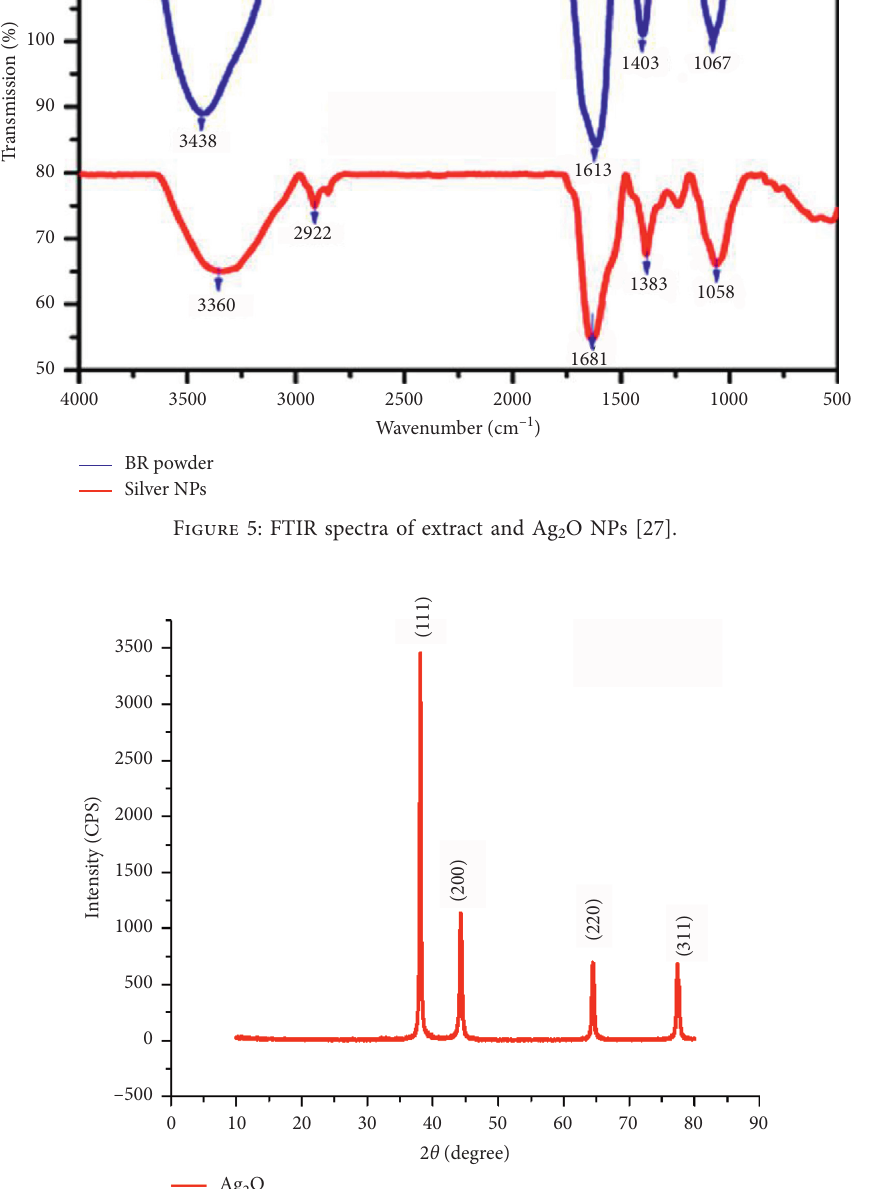
2 O nanoparticles